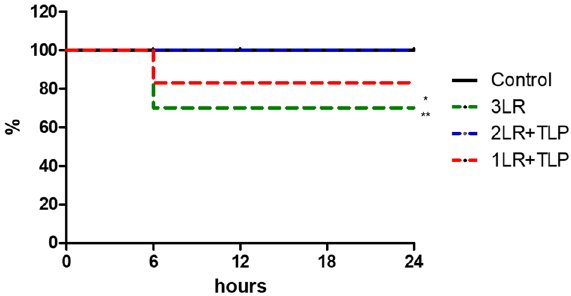
Figure 1. Curve of survival after hemorrhagic shock. * P < 0.05 vs. 2LR + TLP; ** P < 0.01 vs. control; Control, no intervention; 3LR, induction of hemorrhagic shock, followed by infusion of lactated Ringer’s at 3 times the volume of the blood withdrawn; 2LR + TLP, induction of hemorrhagic shock, followed by infusion of lactated Ringer’s at 2 times the volume of the blood withdrawn, together with intravenous injection of terlipressin at 10 µg/100 g body weight; 1LR + TLP, induction of hemorrhagic shock, followed by infusion of lactated Ringer’s at a volume equal to that of the blood withdrawn, together with intravenous injection of terlipressin at 10 µg/100 g body weight.